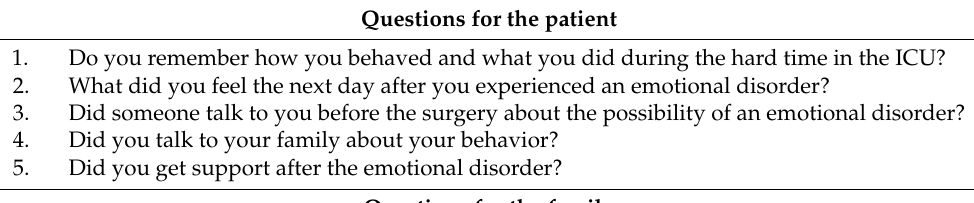
Table 1. Questions for patients and